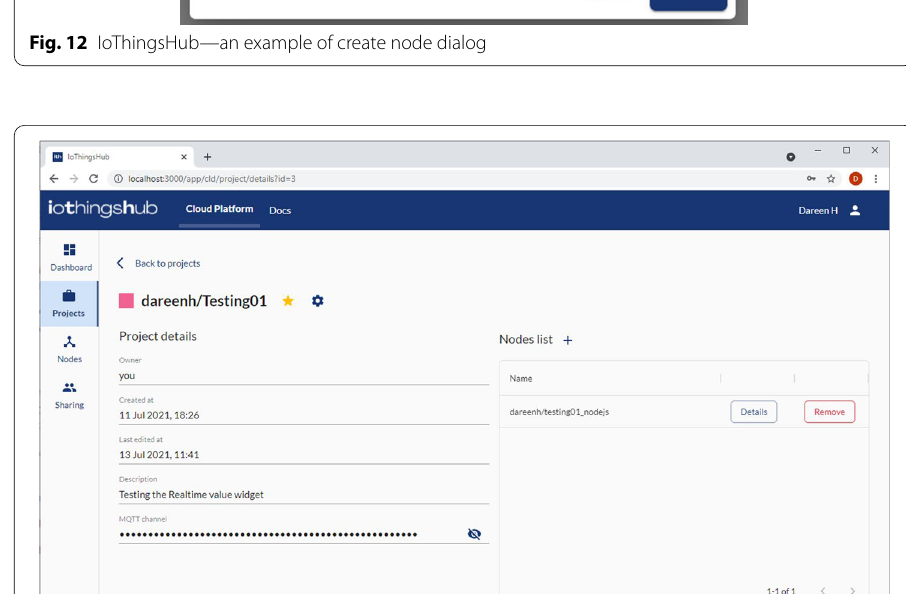
Fig. 13 IoThingsHub—an example of a project